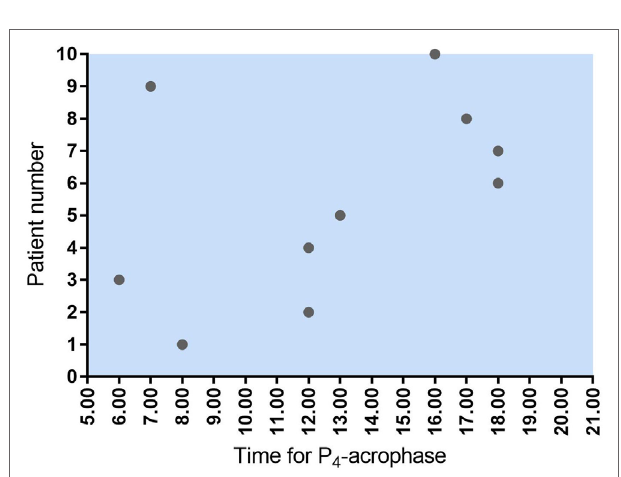
FigUre 4 | Time for maximum P 4 concentration (acrophase) in 10 women undergoing IVF treatment. As seen, five women had their P 4 acrophase before noon and five after noon. The same pattern was seen for P 4 nadir.